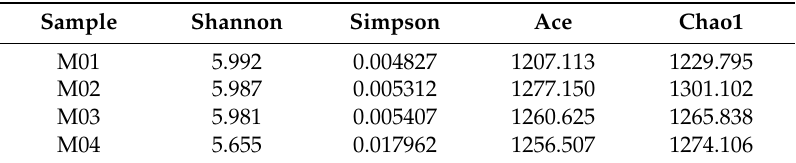
Table 3. Bacterial diversity